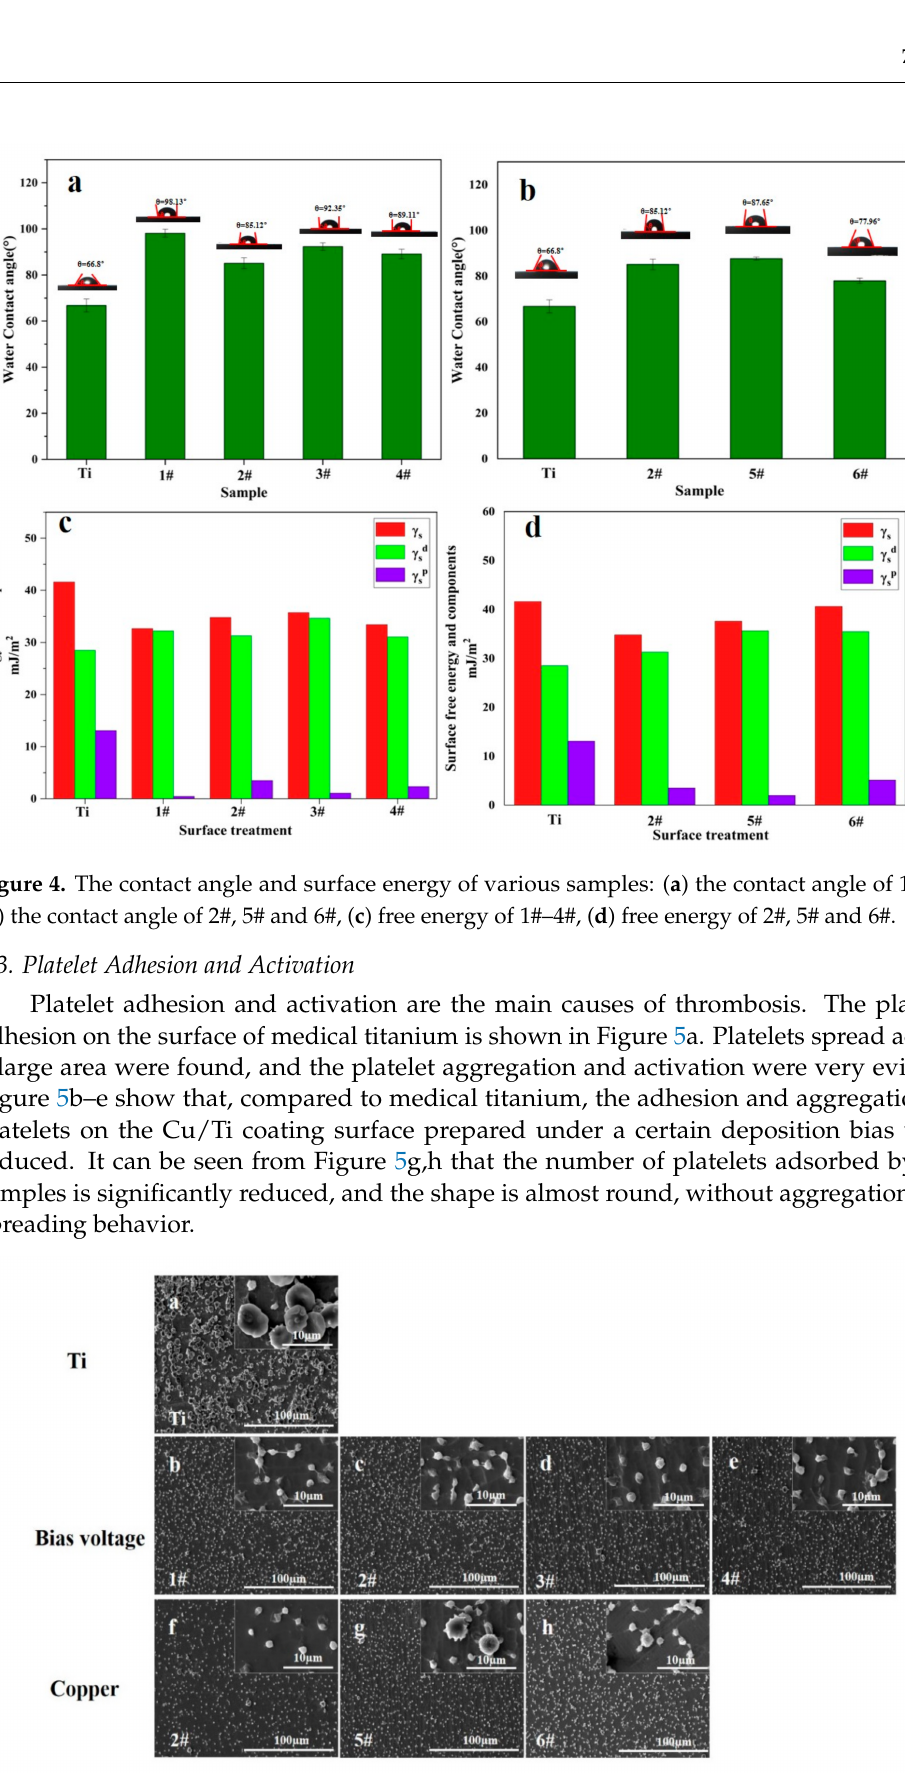
Figure 5. Platelet adhesion of Cu/Ti composite coatings: ( a ) Ti, ( b ) 1#, ( c ) 2#, ( d ) 3#, ( e ) 4#, ( f ) 2#, ( g ) 5#, ( h )